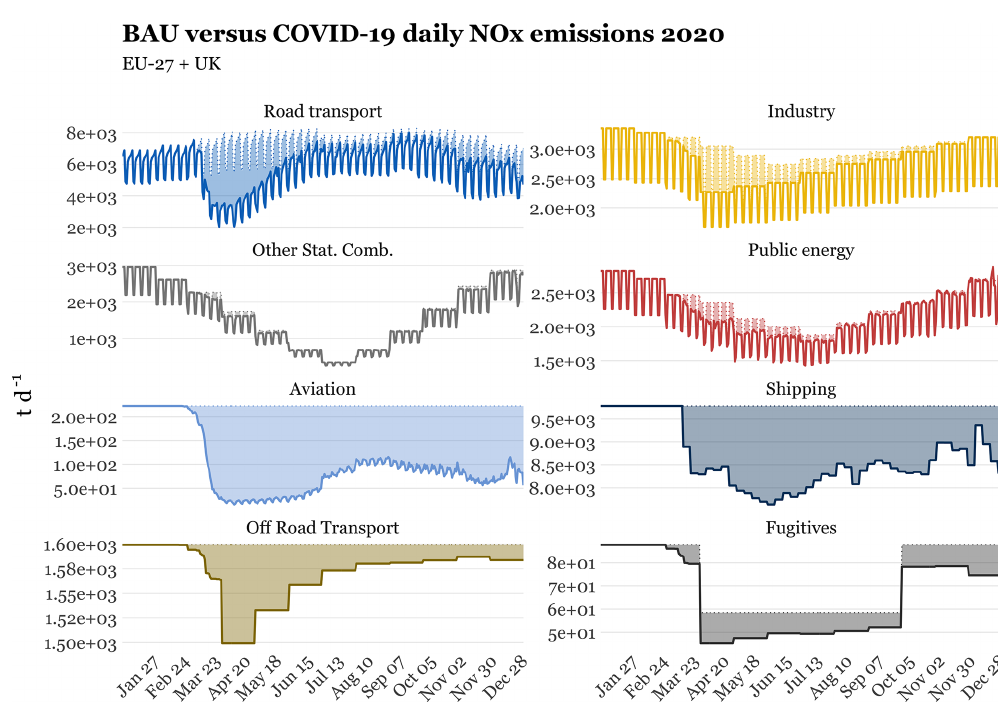
Figure 10. Daily NO x emissions [td − 1 ] by sector computed for the 2020 business-as-usual (dotted line) and COVID-19 (solid line) scenarios between 1 January and 31 December 2020 for EU27 + UK. For the shipping sector the relative differences consider both inland and sea shipping sectors. The areas highlighted between the two lines represent the emission differences between the two scenarios.